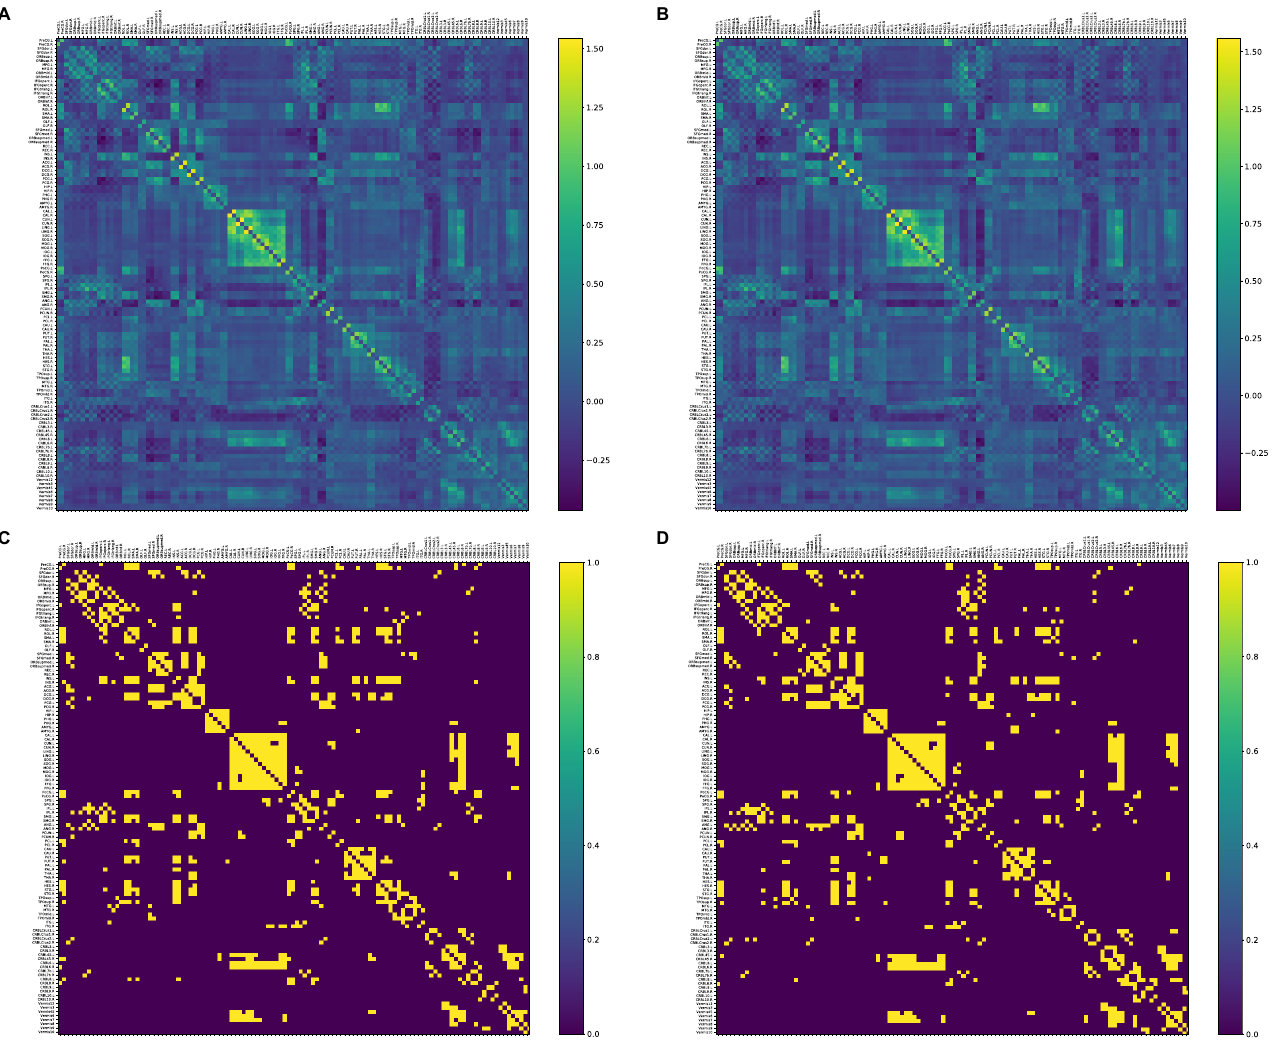
Figure 1. Correlation matrices ( A , B ) (transformed Fisher’s r-to-z) and 10% binarized matrices ( C , D ) for morning and evening sessions, respectively (averaged across all participants in each session). See Appendix A Table A1 for the description of the